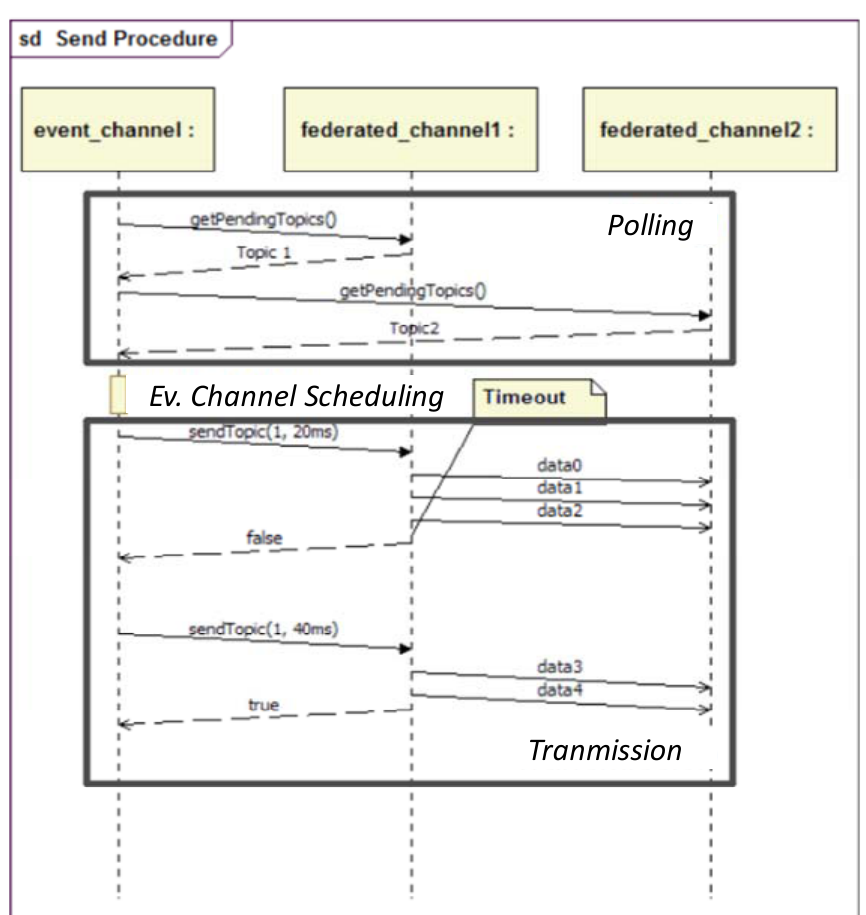
Figure 4. Event channel